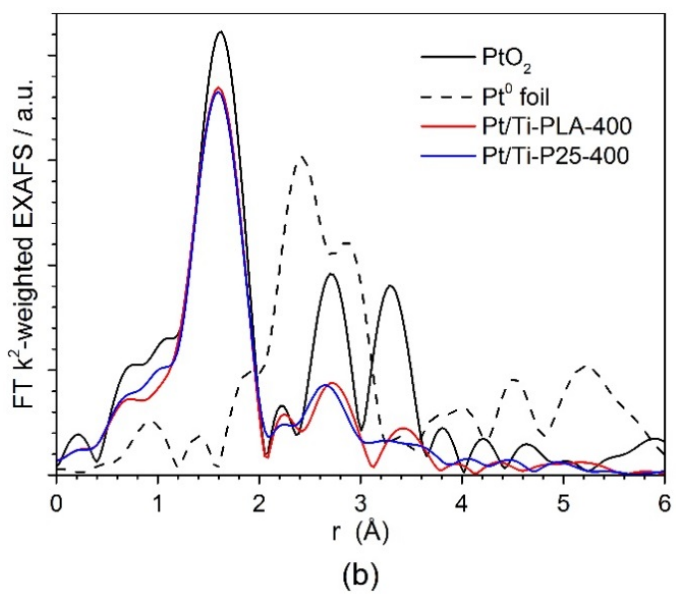
Figure 6. ( a ) Ex situ XANES and ( b ) Fourier transformed (FT) k 2 -weighted EXAFS (uncorrected for the phase shift) spectra of Pt / Ti-PLA and Pt / Ti-P25 samples, and data for PtO 2 and metallic Pt reference samples. The EXAFS is Fourier-transformed in the k-range of: 2.5–11.0 Å − 1 .